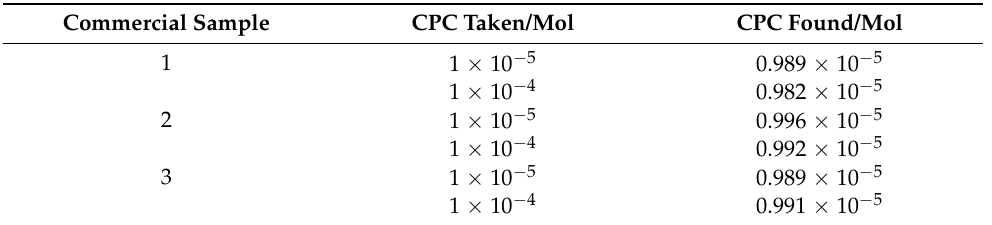
Table 7. Titration of cationic surfactants in commercial samples of disinfectants and antiseptics with